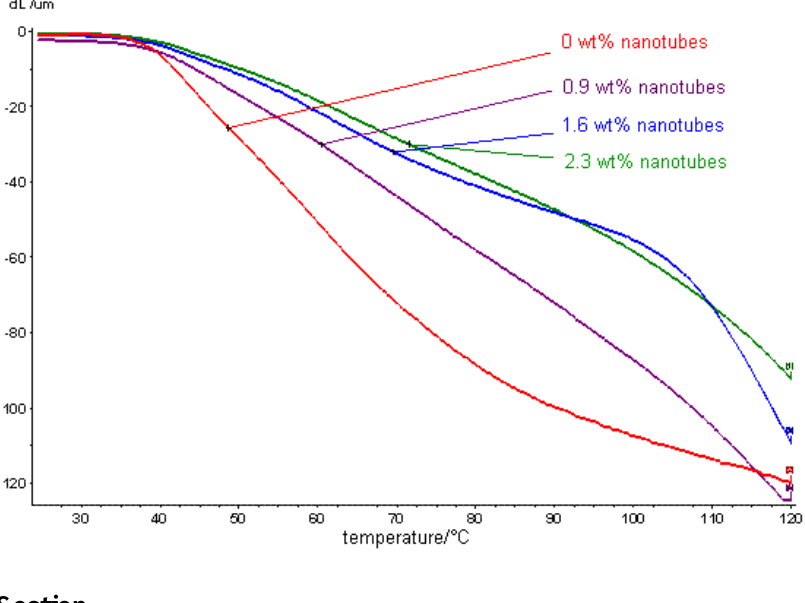
Figure 11. Dynamic mechanical measurements of iPP/MWCNT composites measuring the form stability in dependence of the filler content and